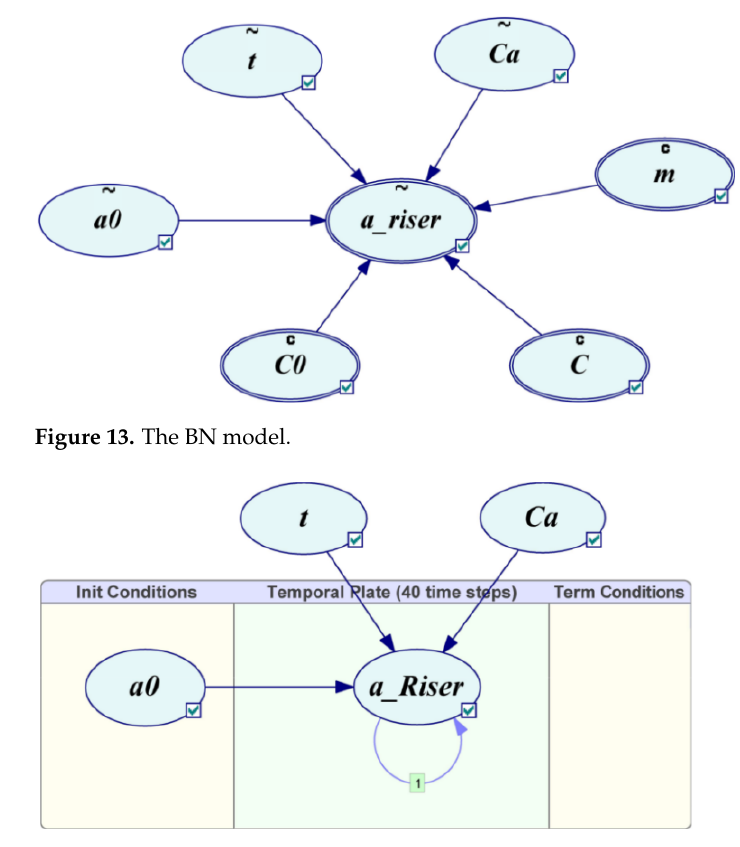
Figure 14. The DBN of fatigue failure.